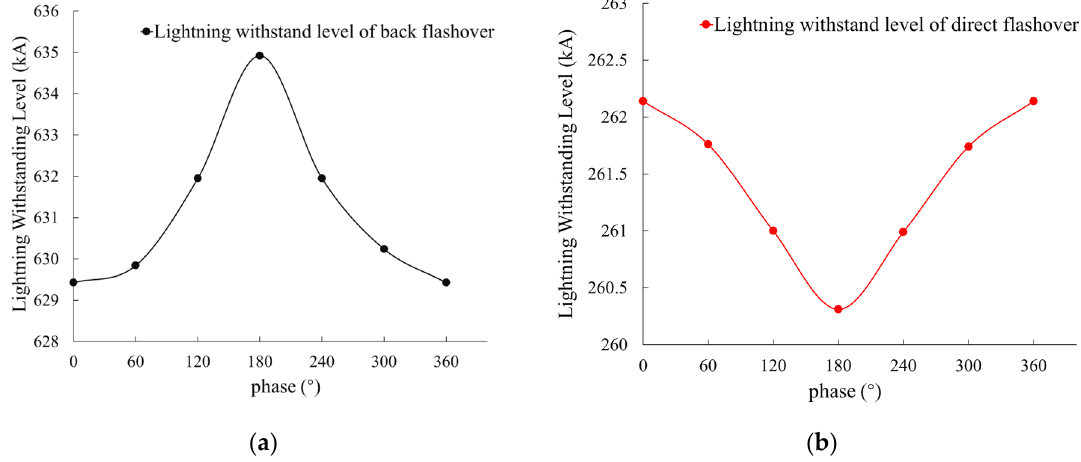
Figure 5. Influence of phase on LWL: ( a ) LWL of back flashover; ( b ) LWL of direct flashover. It was found that when the phase angle of the nominal voltage varies, the LWL